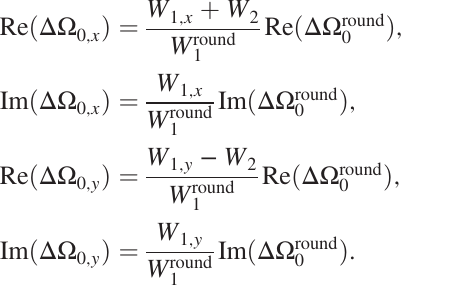
FIG. 16. Envelopes of beam centroid over time with growth